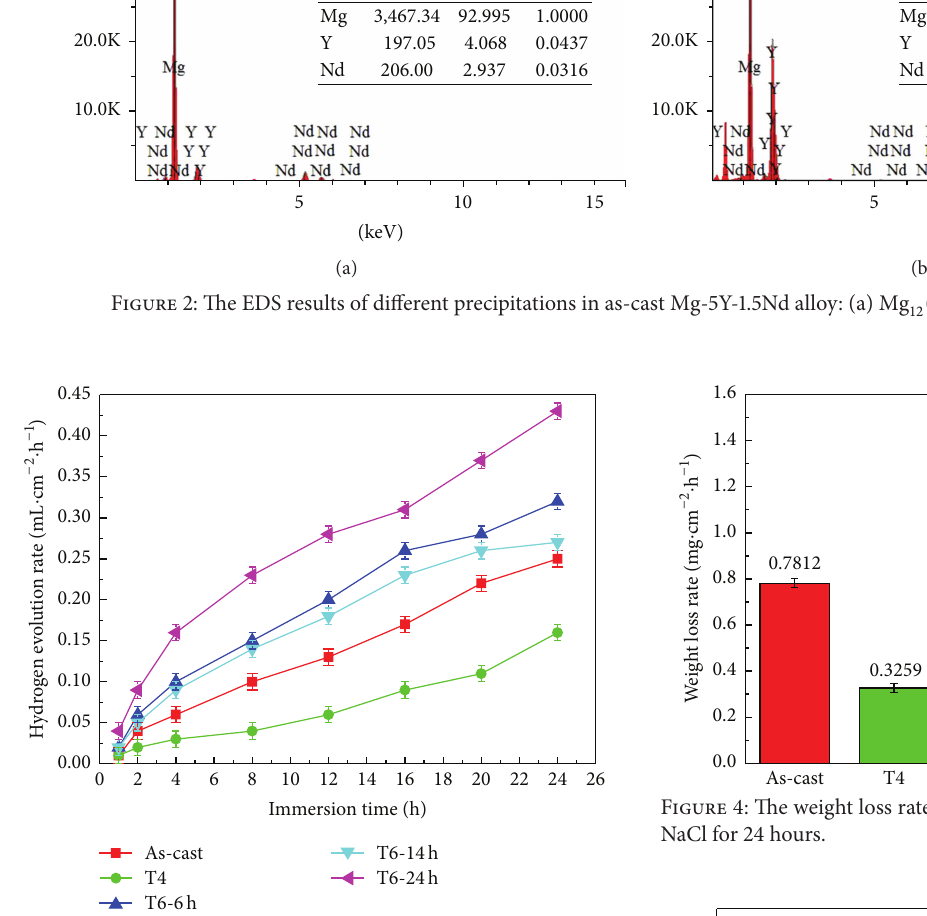
Figure 3: The average hydrogen evolution rates of samples mea- sured in 3.5% NaCl.